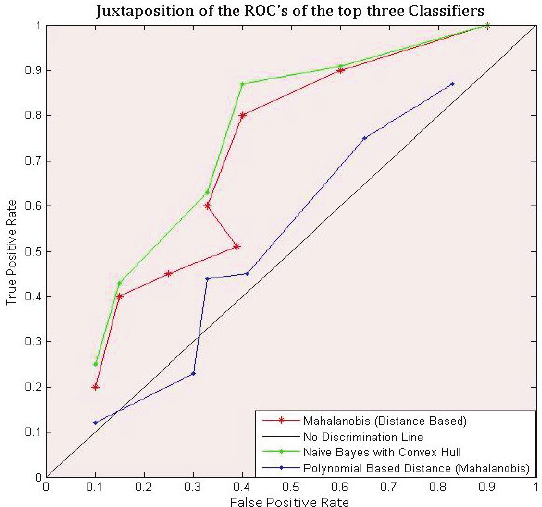
Fig. 21. Comparison of ROC curve for three